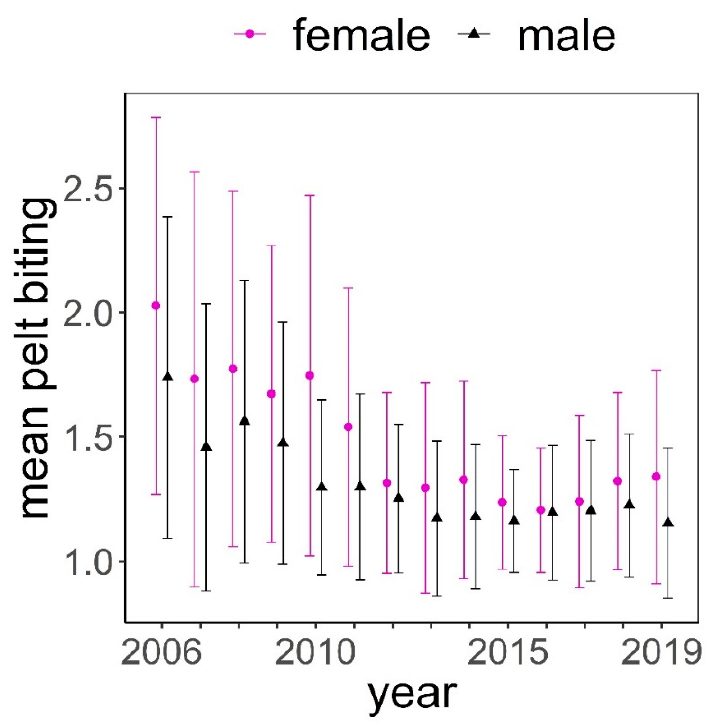
Figure 3. Mean ( ± standard deviation) of pelt biting classes in female (f) and male (m) deer through- out the study period.